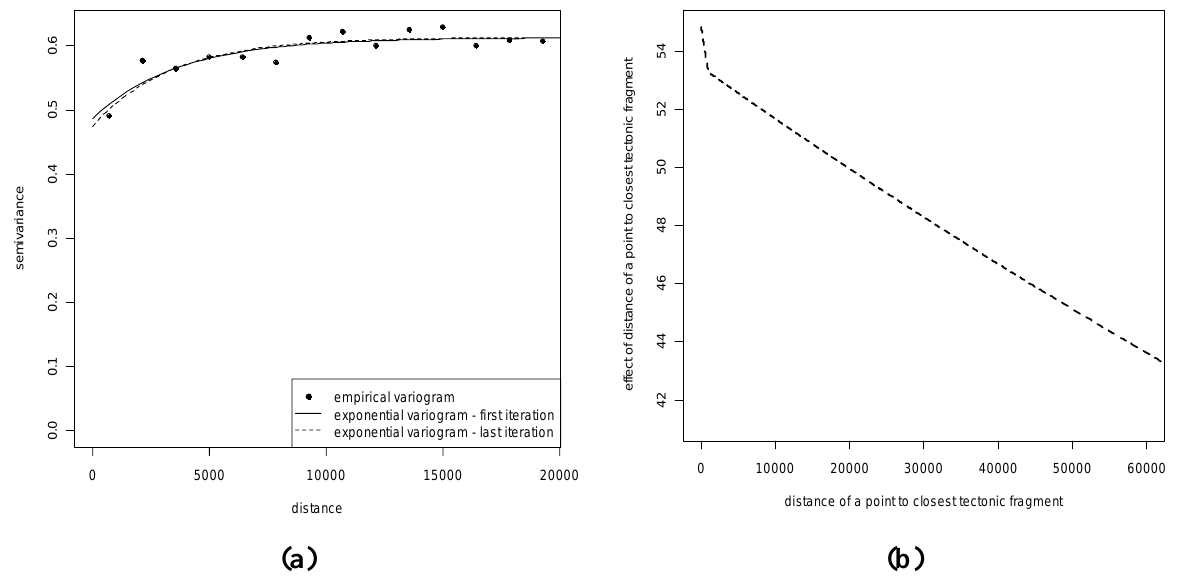
Figure 9. (a) Exponential semi-variograms related to first and last iteration of IRWGLS algorithm. (b) Effect of the distance of a point to the closest tectonic lineament.